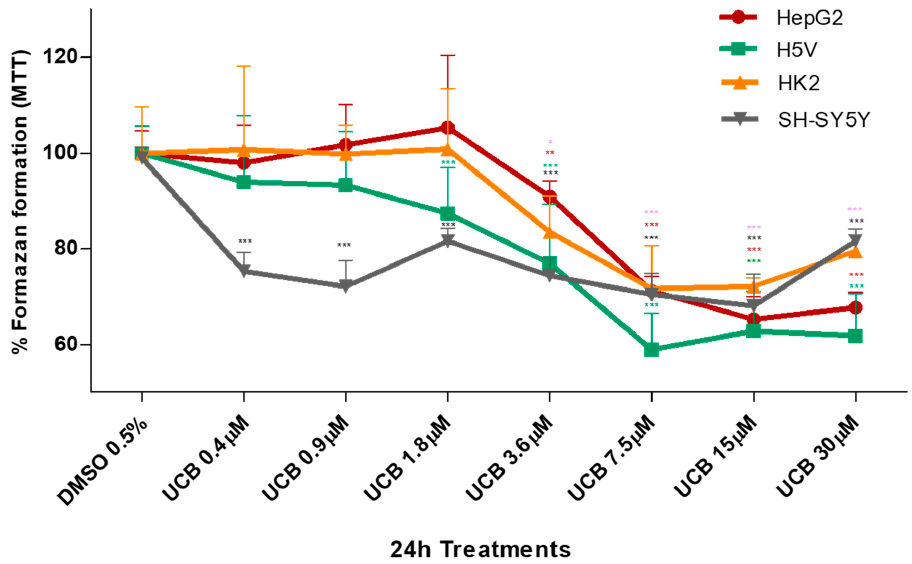
Figure 2. The effect of UCB on the metabolic activity of studied cells. The cell lines were exposed to the increasing UCB concentrations (from 0.4 to 30 µ M in the presence of 30 µ M BSA) or 0.5% DMSO for 24 h and then MTT test was performed. The capacity of control DMSO-treated cells to modify MTT into formazan was considered as 100%. Data are expressed as mean ± SD of at least four independent experiments. * p < 0.05, ** p < 0.01, *** p < 0.00. 2.2. The Effect of UCB Exposure to Intracellular UCB Concentration All four cell lines were exposed for 24 h to increasing UCB concentrations, and then the